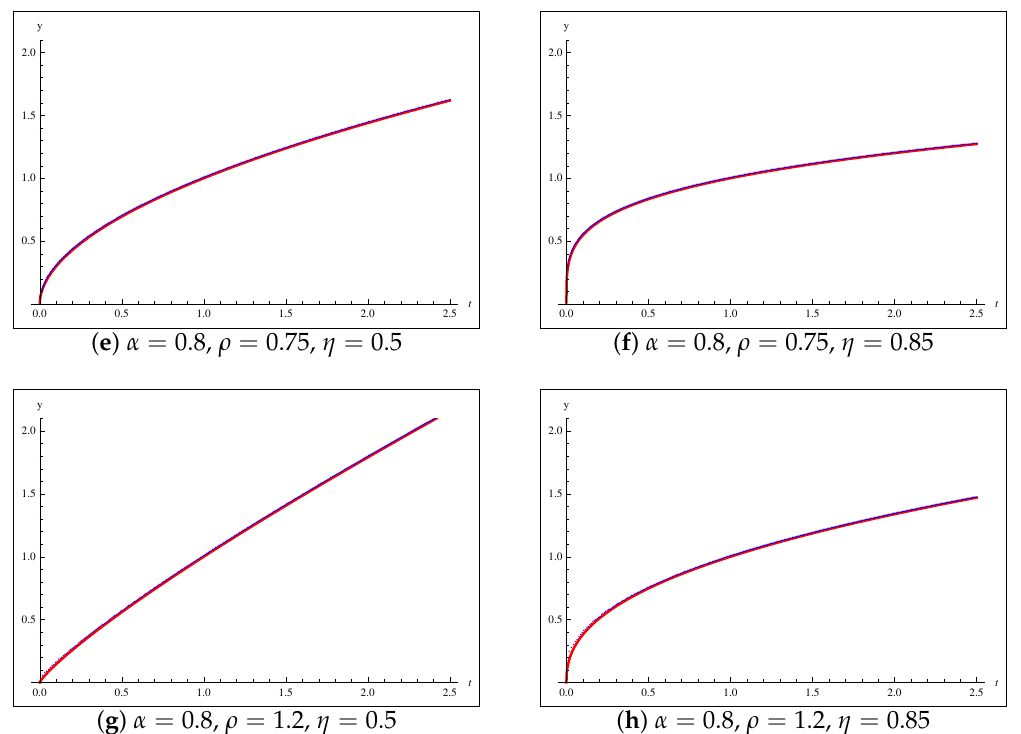
Figure 1. Plots of numerical solutions to the IVP (54), when N = 400: ( Red ) Exact solution; ( Blue ) Predictor-corrector algorithm numerical solutions.